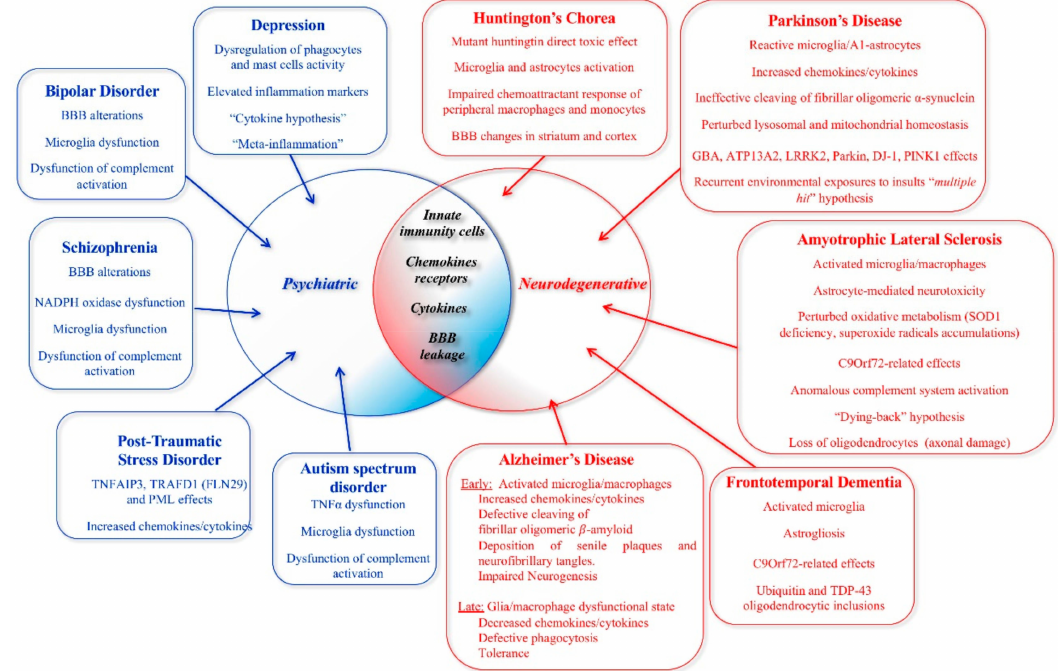
Figure 10. The pathophysiological e ff ects of innate immune dysregulation leading to neuropsychiatric and neurodegenerative